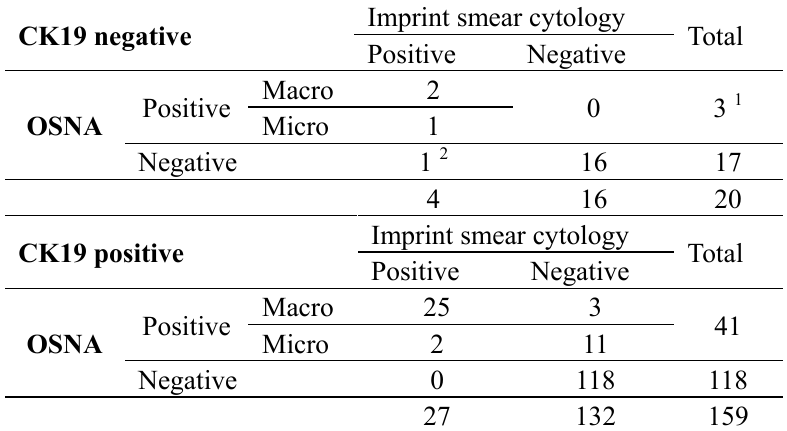
Table 4. OSNA and imprint smear cytology of SLN according to CK19 expression